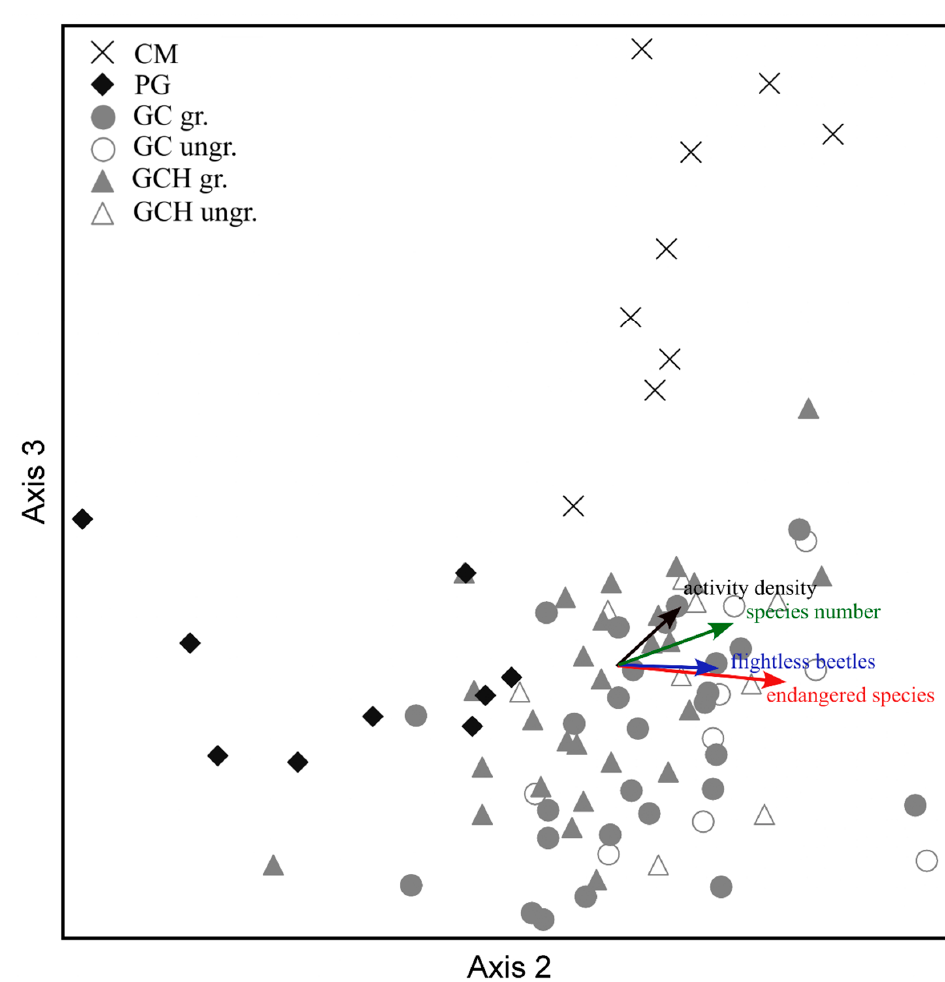
Figure 1. Non-metric multidimensional scaling (NMDS) of carabid assemblages in the different land-use systems (conventional maize CM, organic grass–clover GC, organic grass–clover herbs GCH, organic permanent grasslands PG) and management types (grazed gr., ungrazed ungr.) in early summer. We found correlations with beetle activity density, species richness, endangered spe- cies, and fl ightless species. Carabid assemblages of grass–clover pastures, irrespective of mixture and management, were distinct from the assemblages of CM.